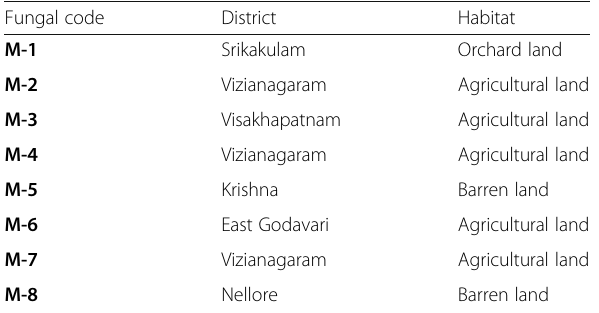
Table 1 Fungal codes, districts, and habitats of Coastal Andhra Pradesh, India